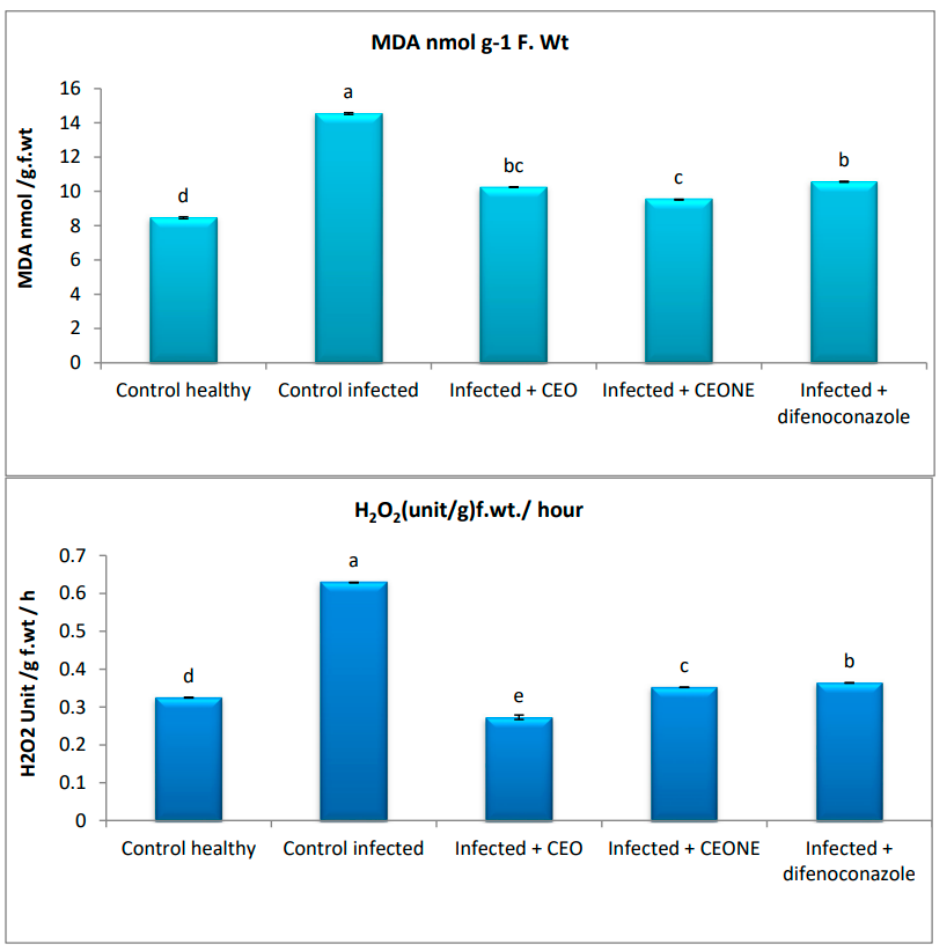
Figure 8. E ff ect of CEO and CEONE on MDA and H 2 O 2 content of C. carvi. Le tt ers a,b,c,d,e mean Figure 8. Effect of CEO and CEONE on MDA and H 2 O 2 content of C. carvi . Letters a,b,c,d,e mean power of signi fi cance power of